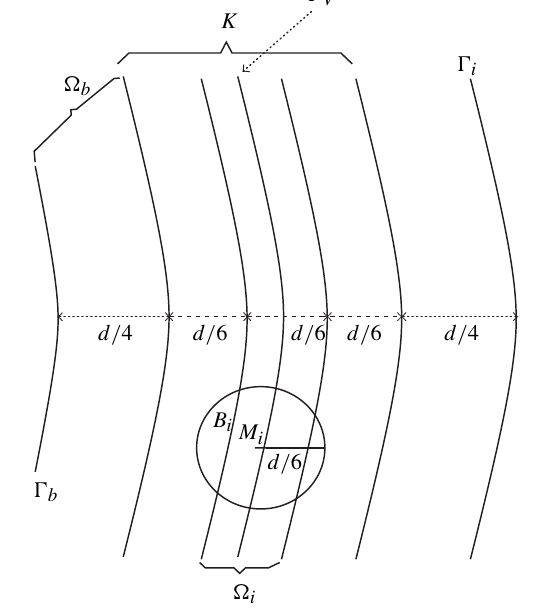
Figure 7.1. Description of the local domain (cid:1) l and the splitting used in the majorization of the global solution.